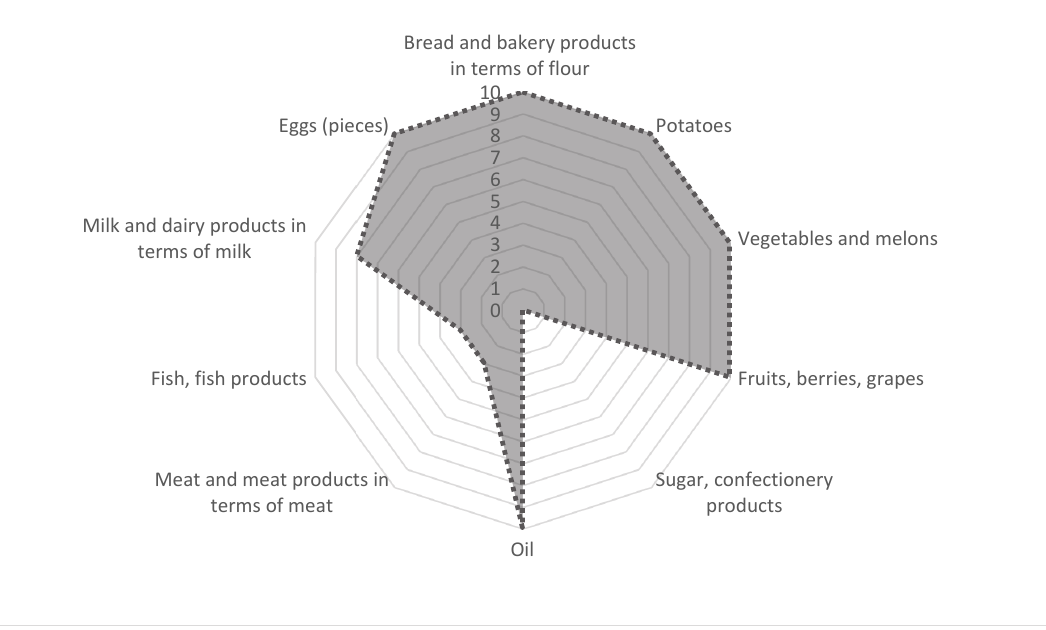
Fig. 4. Food independence potential of the Black Sea region in terms of basic food